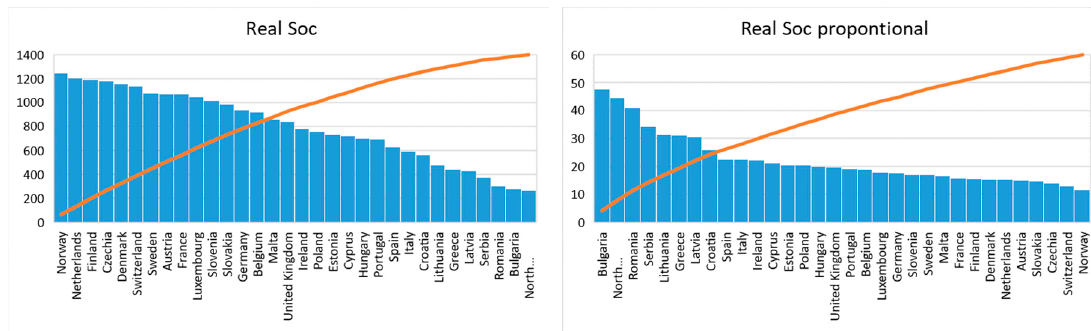
Figure 30. Compared real values, Soc factors.